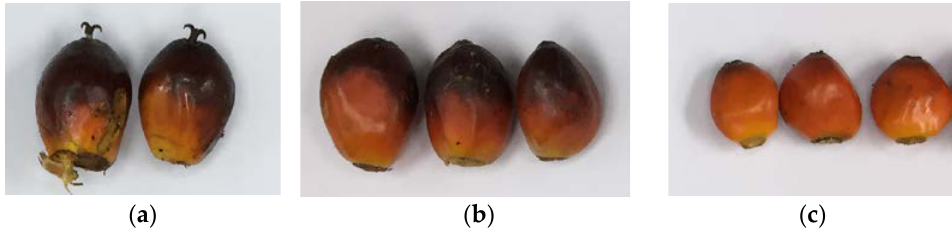
Figure 1. Fresh oil palm fruitlet samples: ( a ) Under-ripe fruitlets; ( b ) Ripe fruitlets; ( c ) Over-ripe fruitlets.